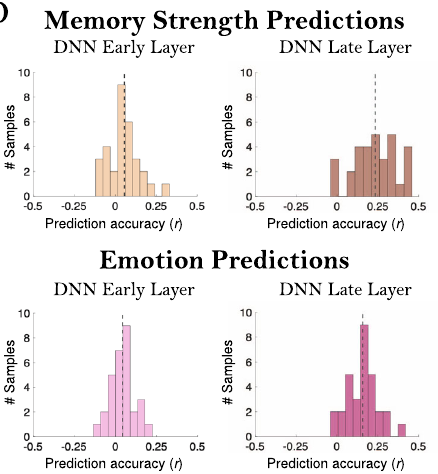
Fig. 5 | Signi fi cant effects of memory and emotion in the hippocampus and deep neural network (DNN) predictions. a Betas for all participants in the com- bined model predicting hippocampal activation from the four factors of memory strength, emotion rating, age (time from scan), and distance from scan site. Each pointindicates one ofthe 32samples, and the barindicates the average betavalue across participants. Note the much more constrained y-axis needed to display the age and distance factors (beta range of − 0.15 to 0.15) versus the memory and emotion factors (beta range of − 30 to 30). While memory strength ( p =1.57×10 − 4 ) and emotion ( p =0.009) show a signi fi cant positive relationship to hippocampal activation,ageanddistancedonot( p >0.10).Signi fi cancewasassessedwithatwo- sided t-test versus 0, with FDR correction across ROIs, q <0.05. b Prediction